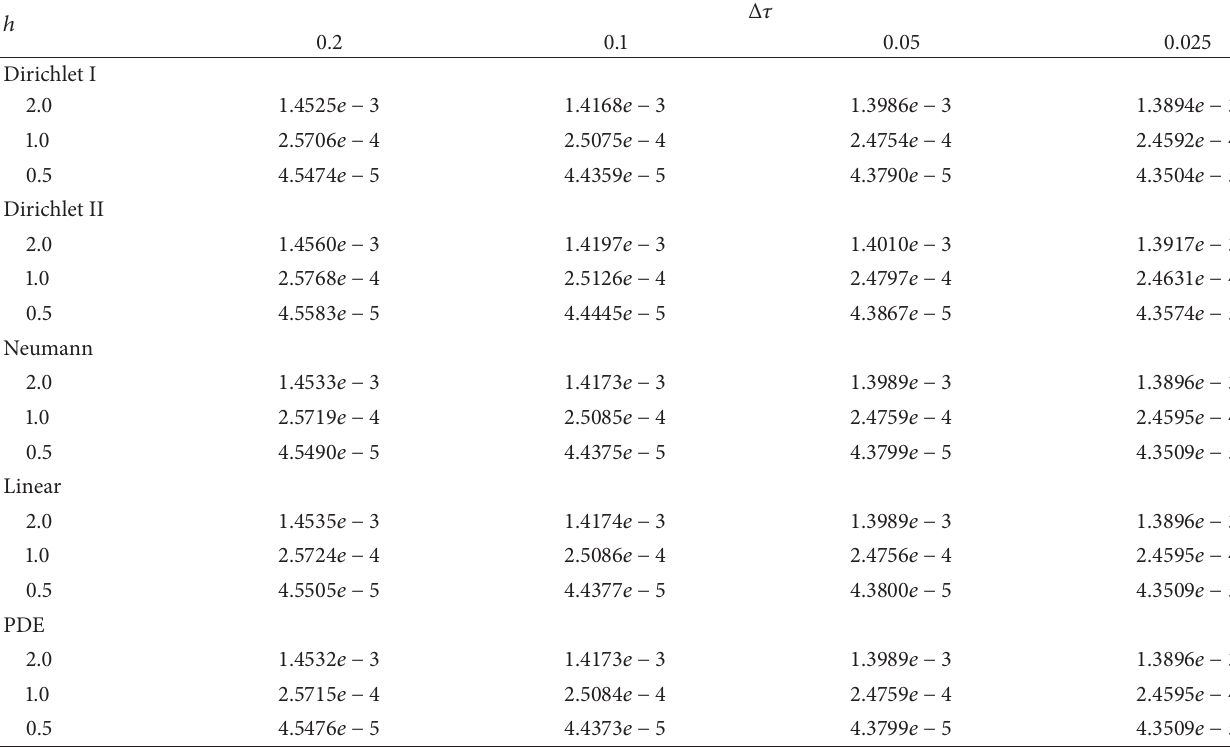
Table 1: RMSE for European call option with varying ℎ and Δ𝜏 with five different